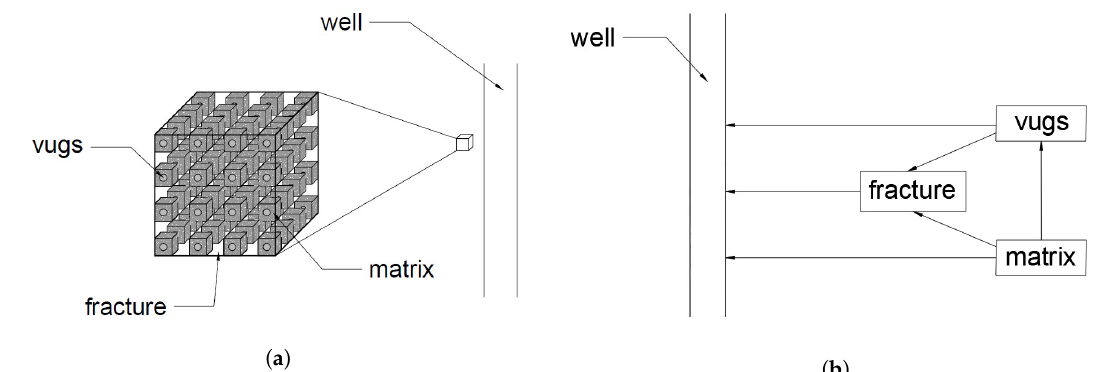
Figure 1. ( a ) Idealized model to triple porosity reservoir. ( b ) Interporosity flow between porous media and well